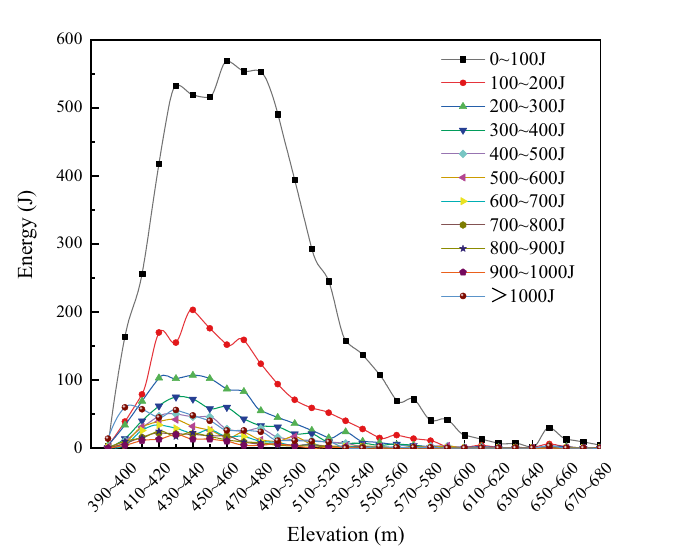
Figure 5. Interval distribution map of the number of microseismic events at an elevation.